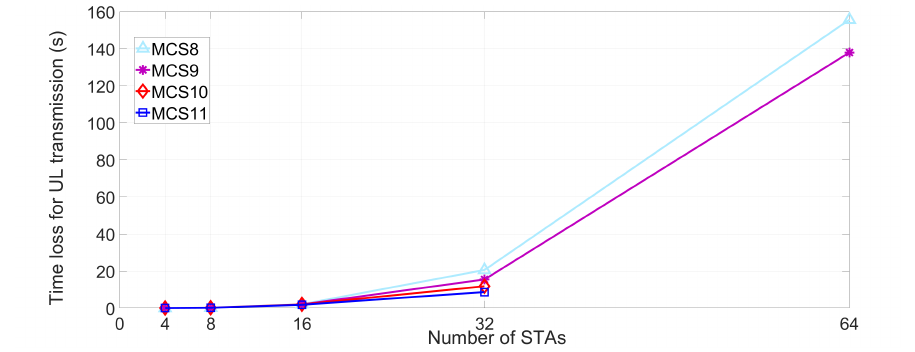
Figure 8. Expected time loss l t for UL transmission.